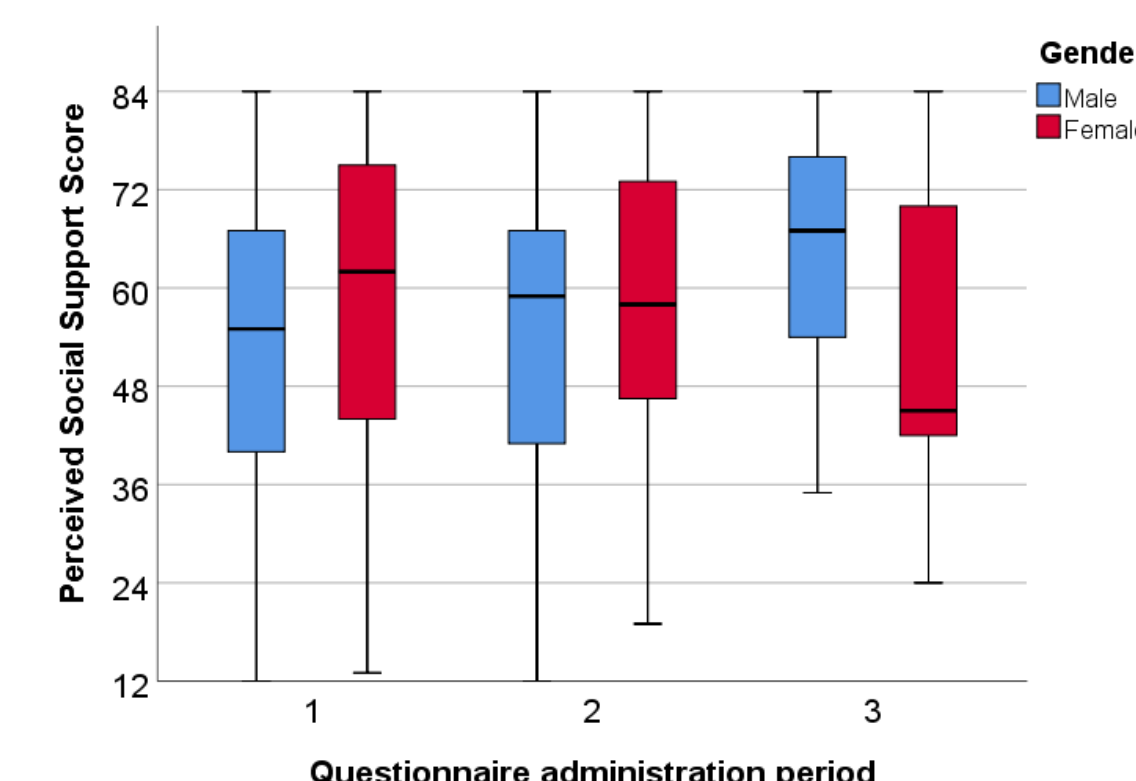
Figure 2. Gender differences in perceived social support among international students.